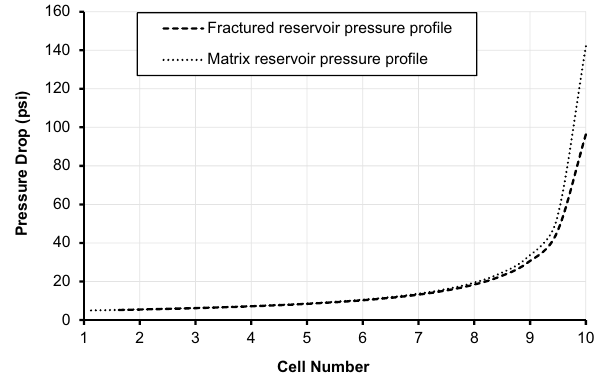
Fig. 9 Effect of asphaltene concentration in oil on permeability alter- ation by asphaltene deposition using k f / k m of 10 and for 1 year of pro- duction